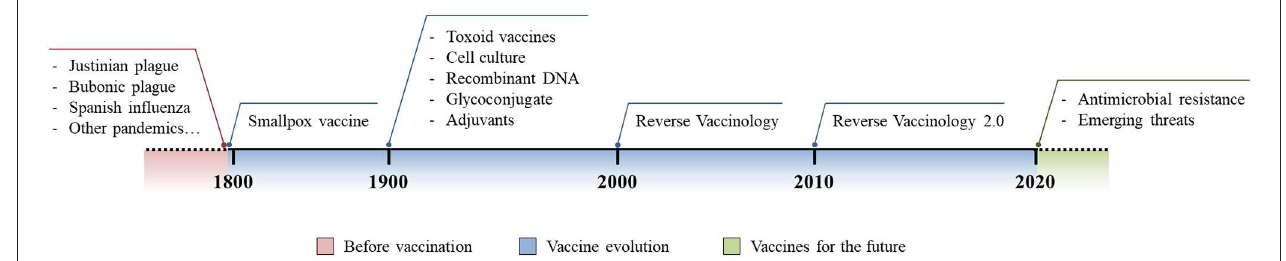
FIGURE 1 | Vaccine evolution. Schematic representation of the burden of infectious diseases before vaccination was introduced (red), technological and methodological advances in vaccinology following the introduction of the first vaccine (blue), and the future use and implementation of vaccine development to fight modern threats